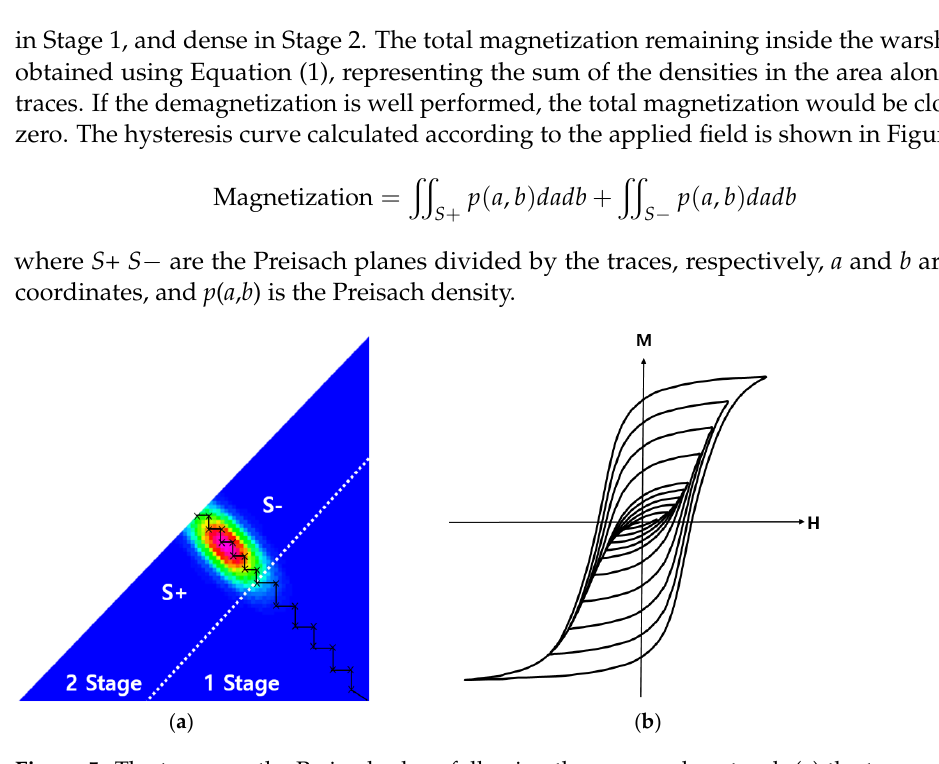
Figure 5. The traces on the Preisach plane following the proposed protocol: ( a ) the traces on the Preisach plane; ( b ) magnetization (M) – magnetic field strength (H) curve.